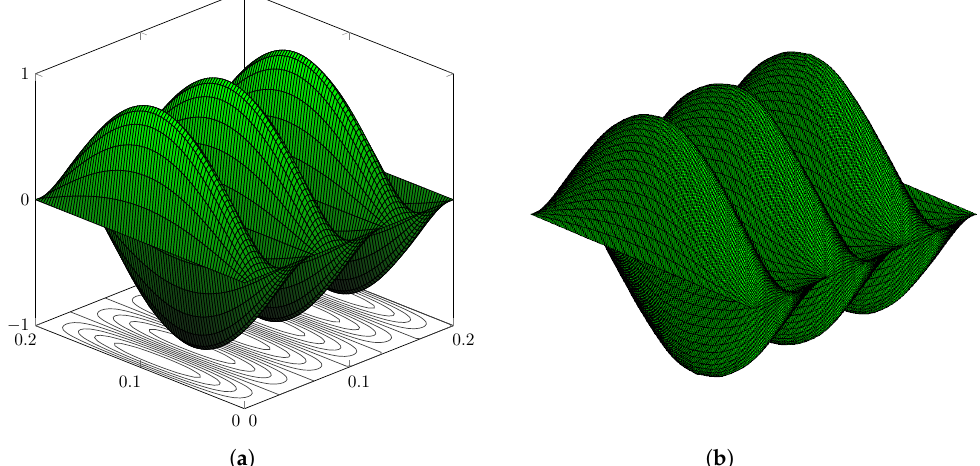
Figure 7. Simply supported LRMP in Figure 3, real part of Mode 150: ( a ) dynamic-stiffness approach and ( b ) finite-element